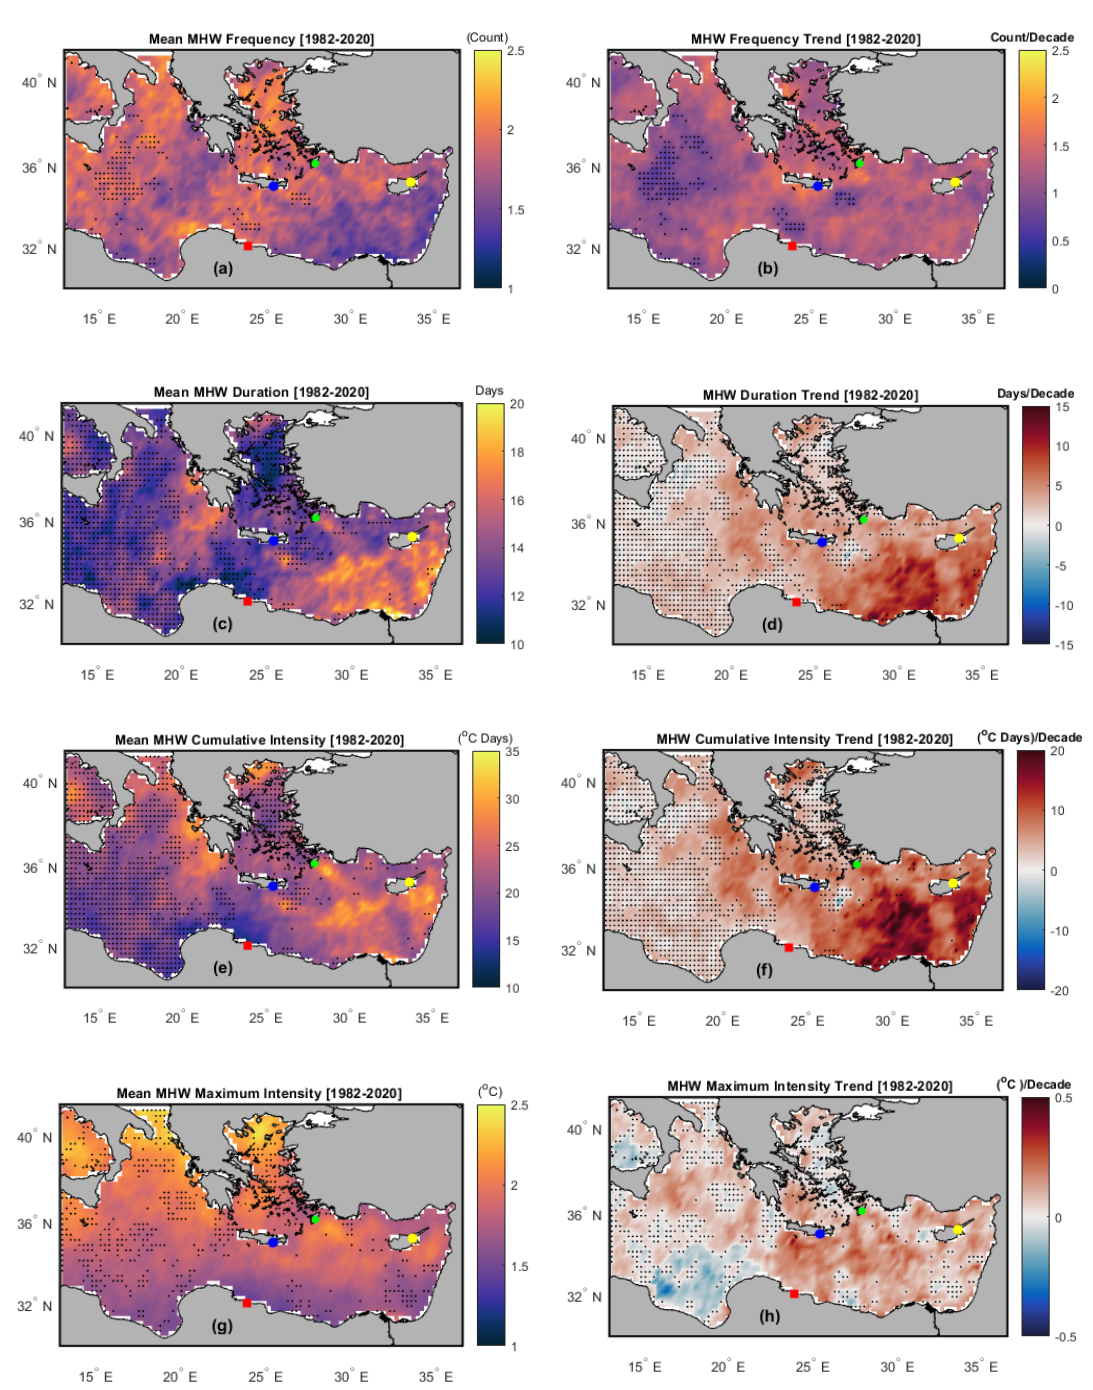
Figure 6. The Marine heatwave properties over the 1982–2020 period, averaged time series of ( a ) mean MHW frequency (Count), ( b ) MHW frequency trend (Count/Decade), ( c ) mean MHW duration (Days), ( d ) MHW duration trend (Days/Decade), ( e ) mean MHW (i cum ) ( ◦ C Days), ( f ) MHW (i cum ) trend ( ◦ C Days/Decade), ( g ) mean MHW (i max ) ( ◦ C), ( h ) MHW (i max ) trend ( ◦ C/Decade), and the black dots indicate the change is not significantly different ( p > 0.05). Where, the solid red square is the position of Mersa Matruh City, the solid blue circle is the position of Crete, the solid green circle is the position of Rhodes, and the solid yellow circle is the position of